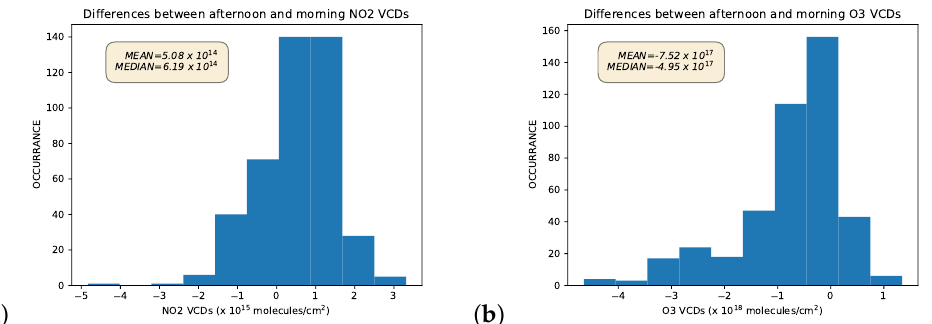
Figure 8. Histogram of the differences computed as NO 2 ( a ) and O 3 ( b ) VCDs in the afternoon minus the VCDs in the morning. For each day, VCDs representative of morning and afternoon were computed as the mean VCDs in the SZA range between 60 ◦ and 90 ◦ .